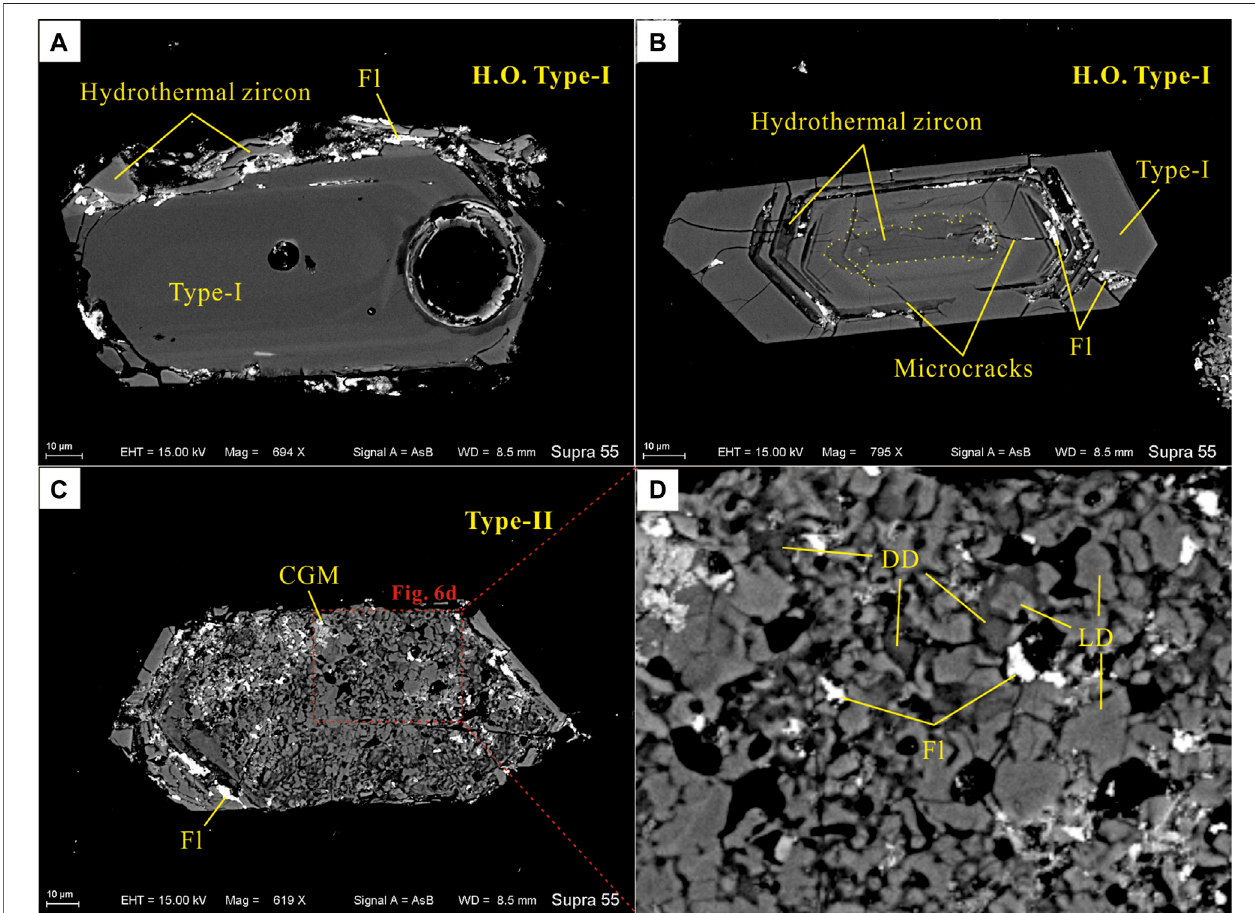
FIGURE 6| Backscattered electron (BSE) images of zircons from the BST pluton. Fl – fl uorite, CGM – columbite group minerals. (A) Hydrothermal zircon and fl uorite occur around the type – I zircon crystal. The circle is the laser spot. (B) F – rich hydrothermal alteration occurs along the growth zoning and fractures in inner zone of the type – Izircon.MicrocracksintheH.O.type – Izirconarepartially fi lledwith fl uorite. (C) Type – IIzircons,withacomplexinternalstructure,containlargeamountof fl uorite(Fl) and columbite group mineral (CGM) inclusions in their crystals. (D) Closeup of the type – II zircon with the light domains (LD) and dark domains (DD). The fl uorite (Fl) inclusions are embedded in microcraks and voids in type – II zircon.